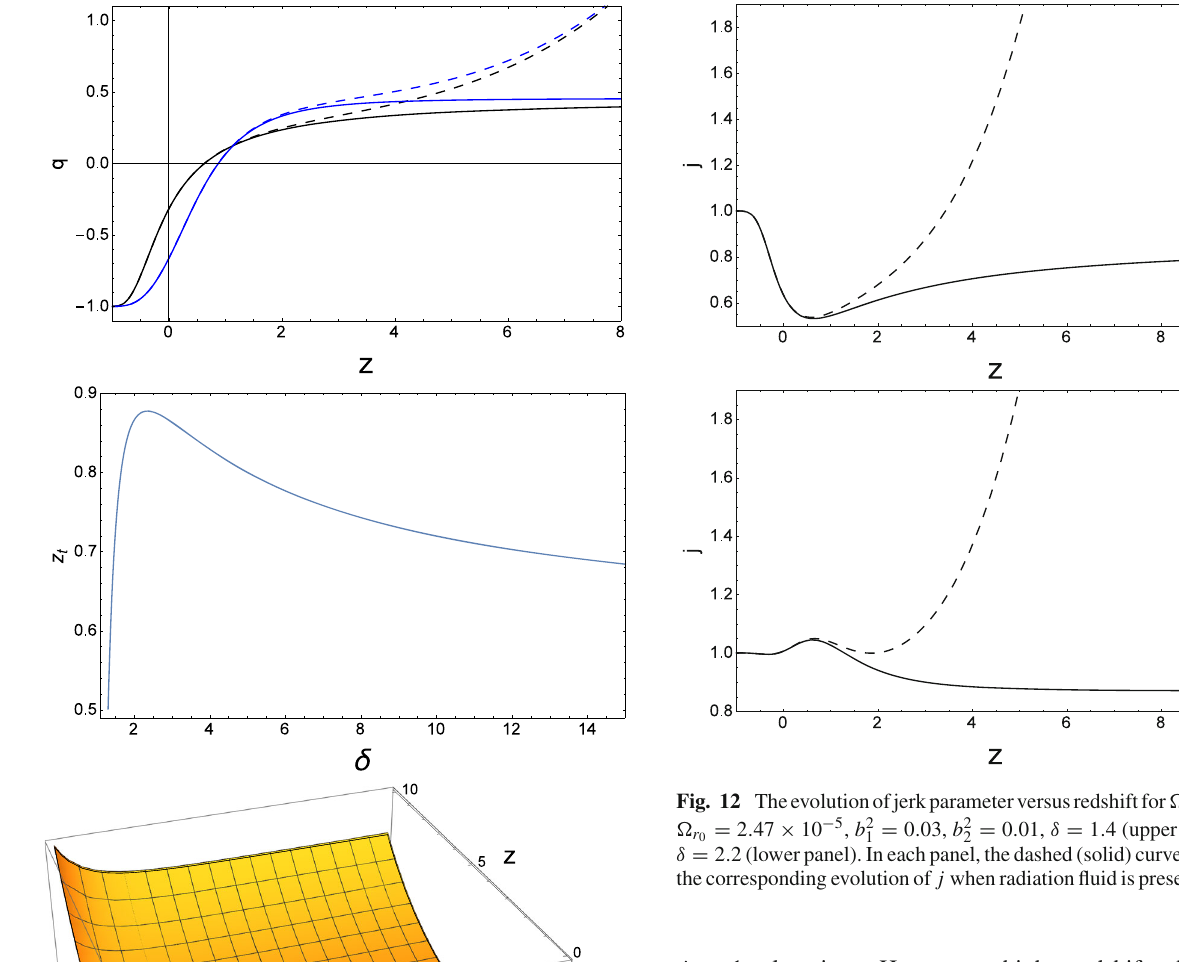
Fig. 12 Theevolutionofjerkparameterversusredshiftfor (cid:5) 0 (cid:5) = 2 . 47 × 10 − 5 , b 2 = 0 . 03, b 2 = 0 . 01, δ = 1 . 4 (upper panel) and r 0 1 2 δ = 2 . 2 (lowerpanel).Ineachpanel,thedashed(solid)curverepresents thecorrespondingevolutionof j